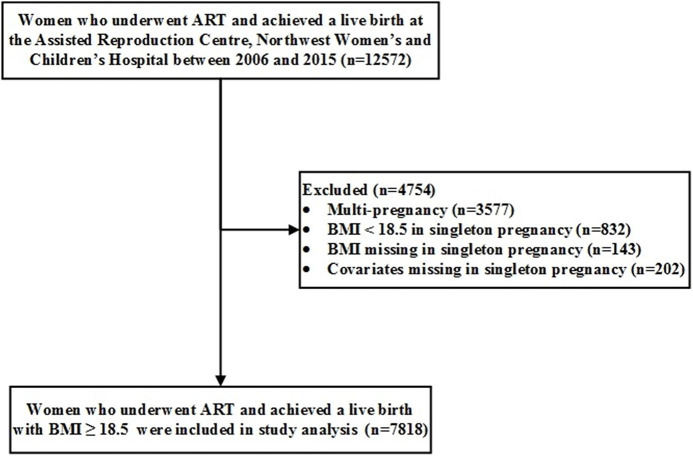
Eligibility assessment with exclusion criteria.